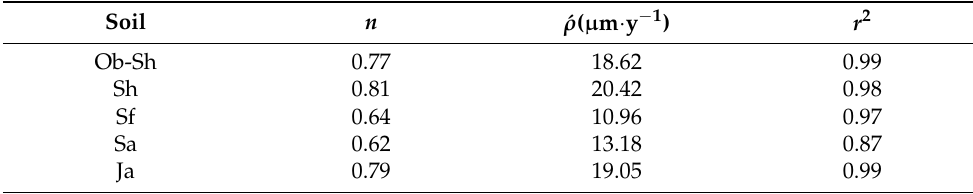
Table 3. Corrosion kinetic parameters for CSX36 corrosion in different Jeddah soil solutions.